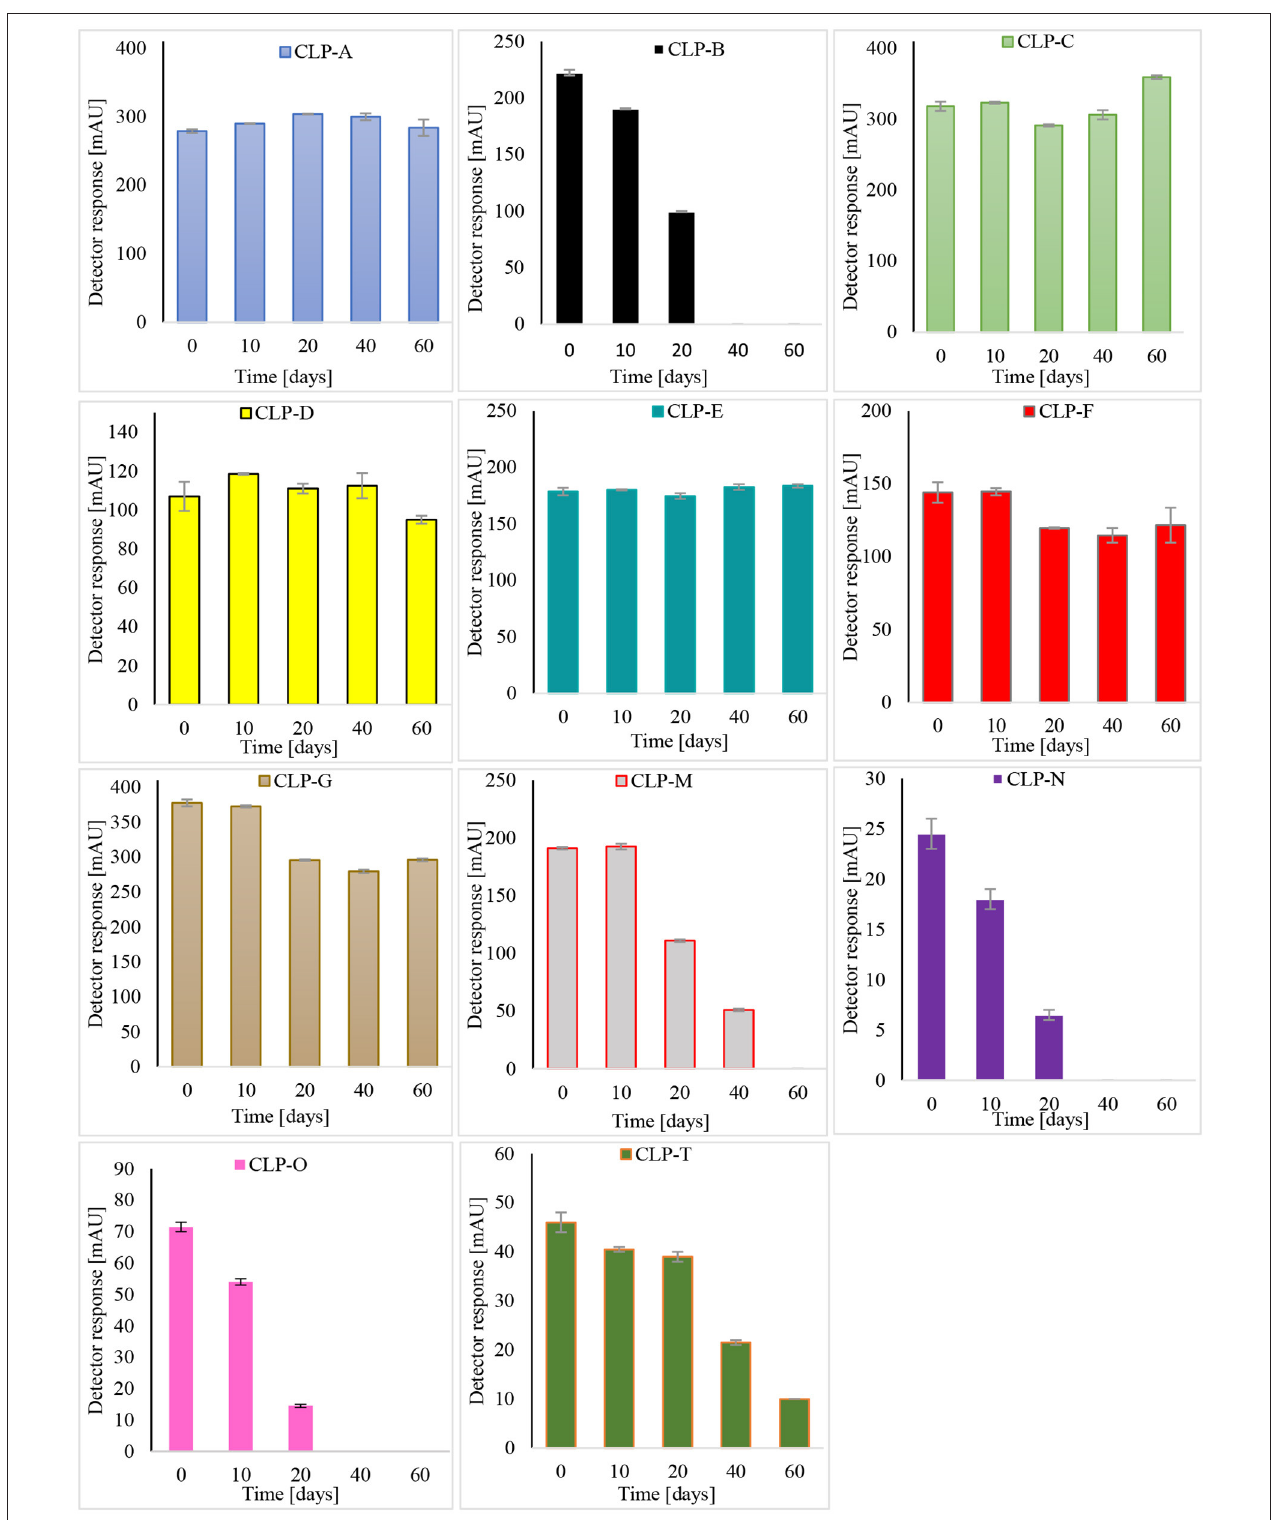
FIGURE 4 | Stability of CLPs at room